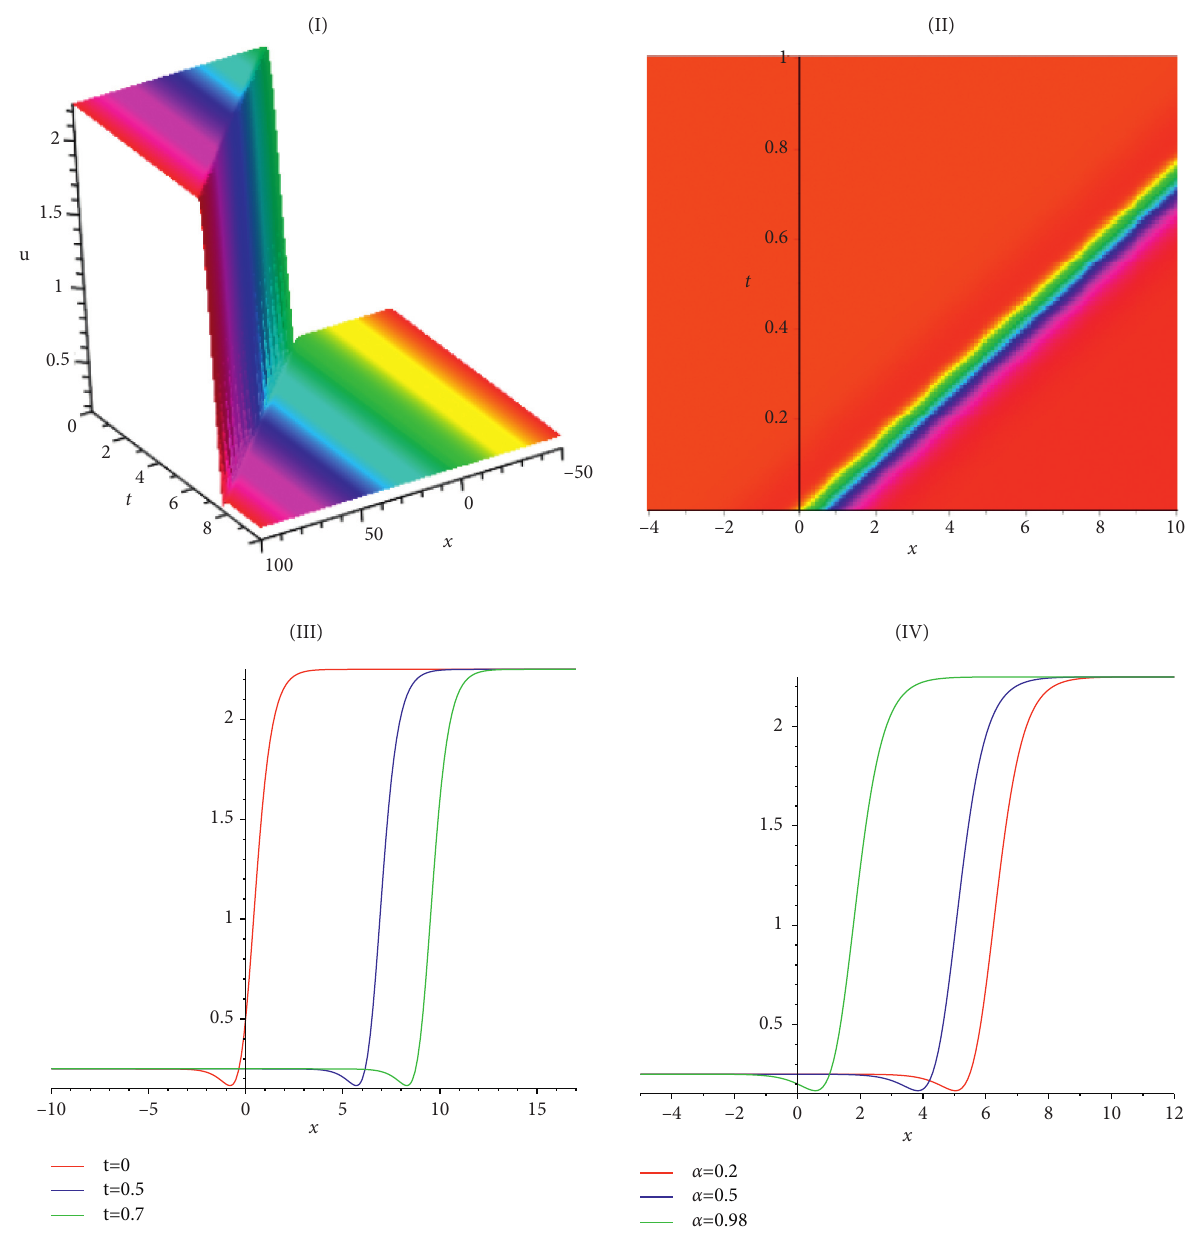
Figure 4: Evolution of the periodic solution (29) with data r � 2 , k